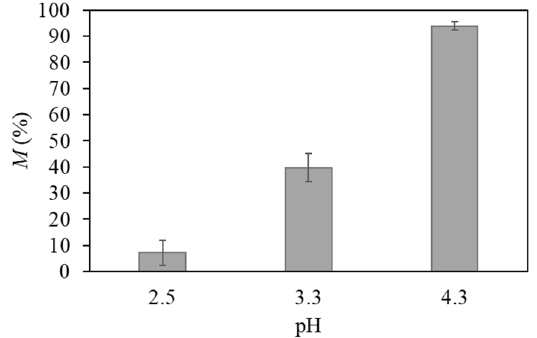
Figure 4. E ff ect of pH in Pb 2 + removal e ffi ciency by FucoPol ( C i 10 mg / L, FucoPol concentration 5 mg / L, Figure 4. Effect of pH in Pb 2+ removal efficiency by FucoPol ( C i 10 mg/L, FucoPol concentration 5 temperature 21 ◦ C, incubation time 24 h). mg/L, temperature 21 °C, incubation time 24 h).